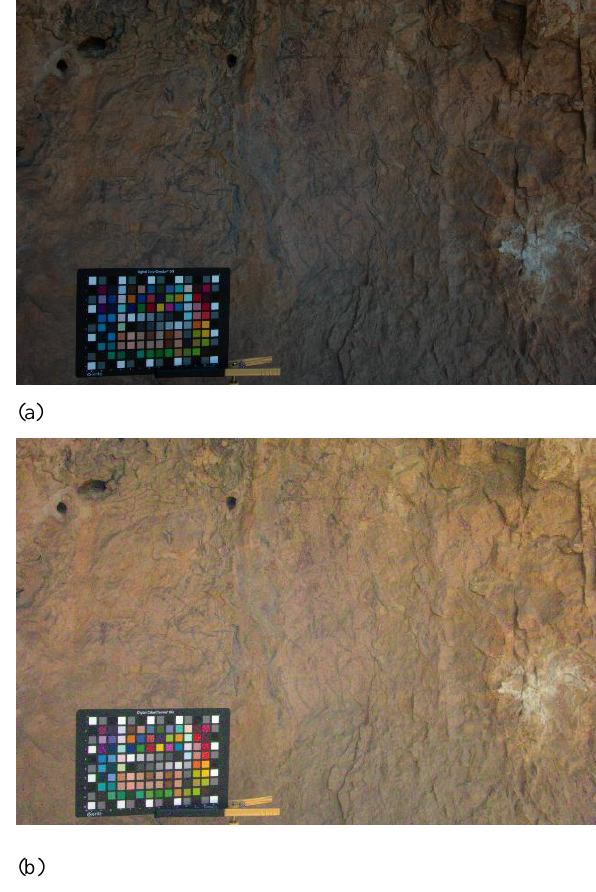
Figure 8. Image SDIM0501.X3F: a) Original RGB image; b) sRGB output image